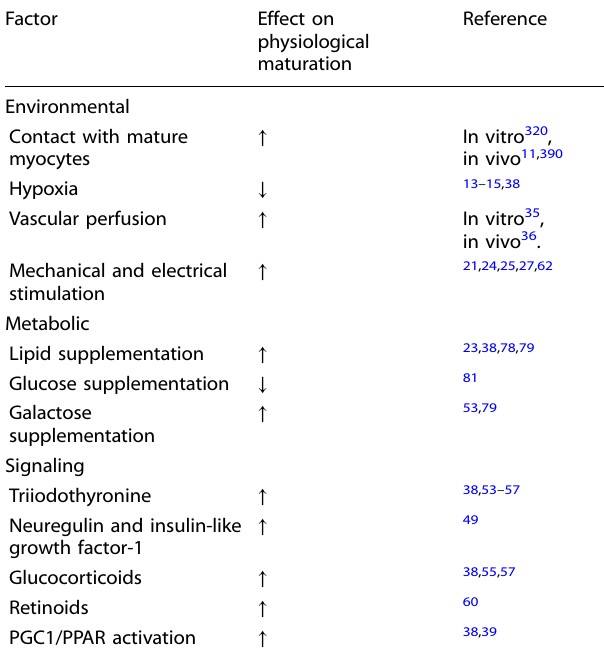
Table 1. Factors in fl uencing myocardial maturation. Factor Effect on physiological